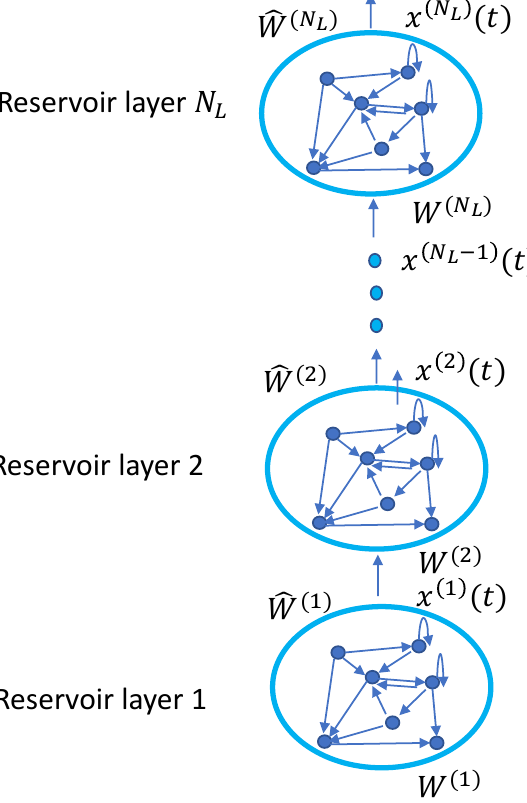
Figure 2. Reservoir